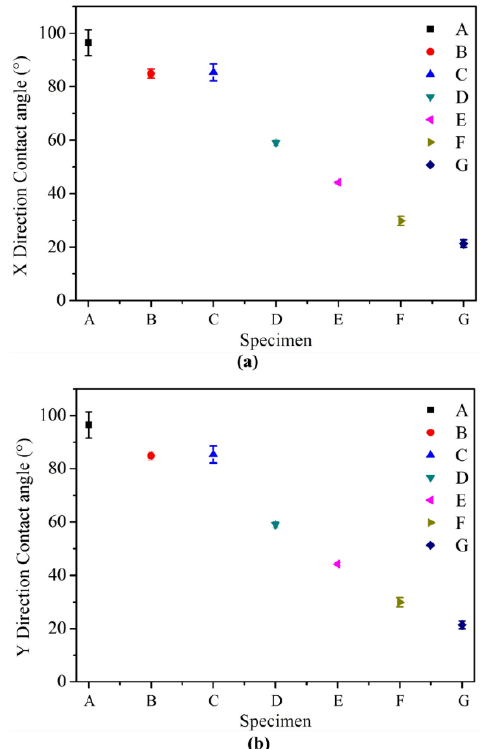
Figure 4. Contact angles of the present specimen A–G with ( a ) X direction and ( b ) Y direction